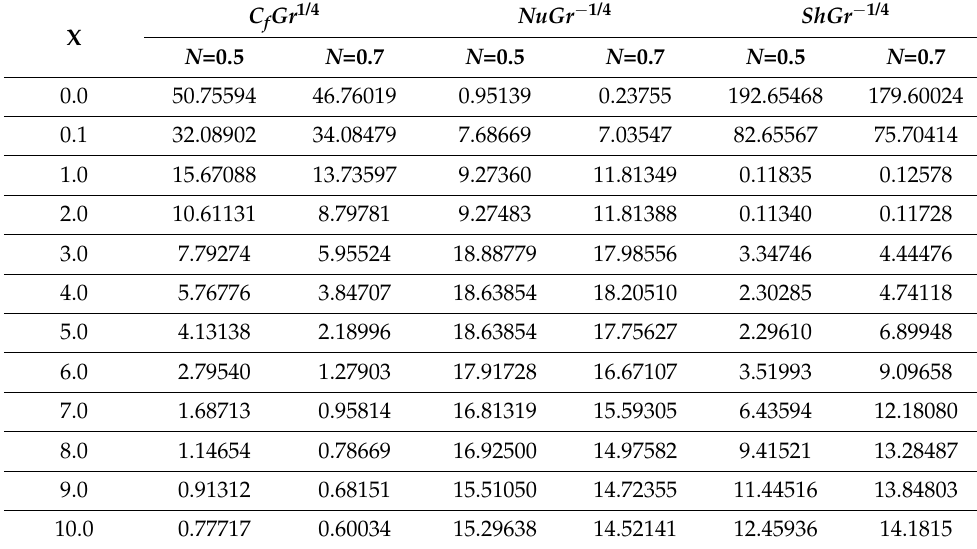
Figure 14. Outcomes of radiation parameter N on mass concentration φ when Nb = 1.5, Nt = 1.5, Pr = 7.0, and Sc = 10.0. Table 6. Outcomes of radiation parameter N on (a) the skin friction coefficient C f Gr 1/4 , (b) Nusselt NuGr − 1/4 , and (c) the Sherwood number ShGr − 1/4 when Nt = 0.2, Nb = 0.3, Sc = 1.0, and Pr = 7.0 .